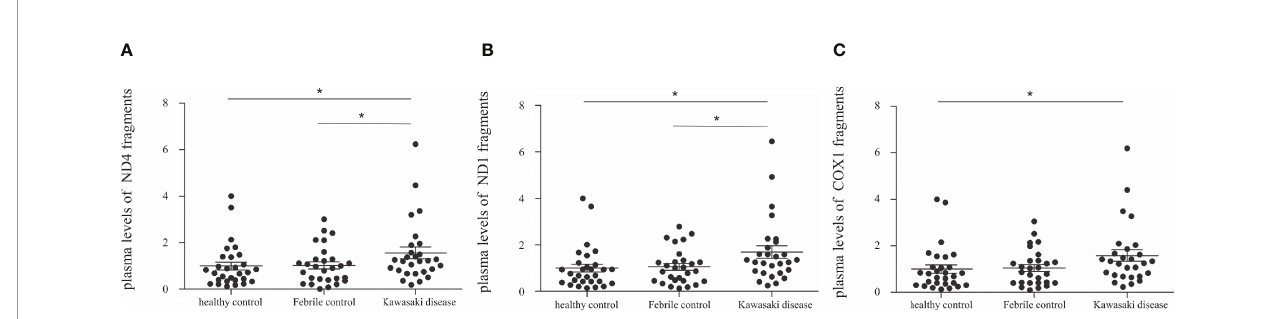
FIGURE 1 | Comparison of cell-free mitochondrial DNA levels in the plasma of patients with Kawasaki disease (KD, n=29), healthy controls (HC, n=29), and febrile controls (FC, n=29). (A) Comparison of ND4 cell-free mitochondrial DNA (mean ± SEM, HC: 1 ± 0.17, FC: 1.02 ± 0.15, KD: 1.56 ± 0.25) (B) Comparison of ND1 cell-free mitochondrial DNA (mean ± SEM, HC: 1 ± 0.17, FC: 1.06 ± 0.14, KD: 1.69 ± 0.26) (C) Comparison of COX1 cell-free mitochondrial DNA (mean ± SEM, HC: 1 ± 0.18, FC: 1.11 ± 0.15, KD: 1.58 ± 0.25). An asterisk denotes a p-value of less